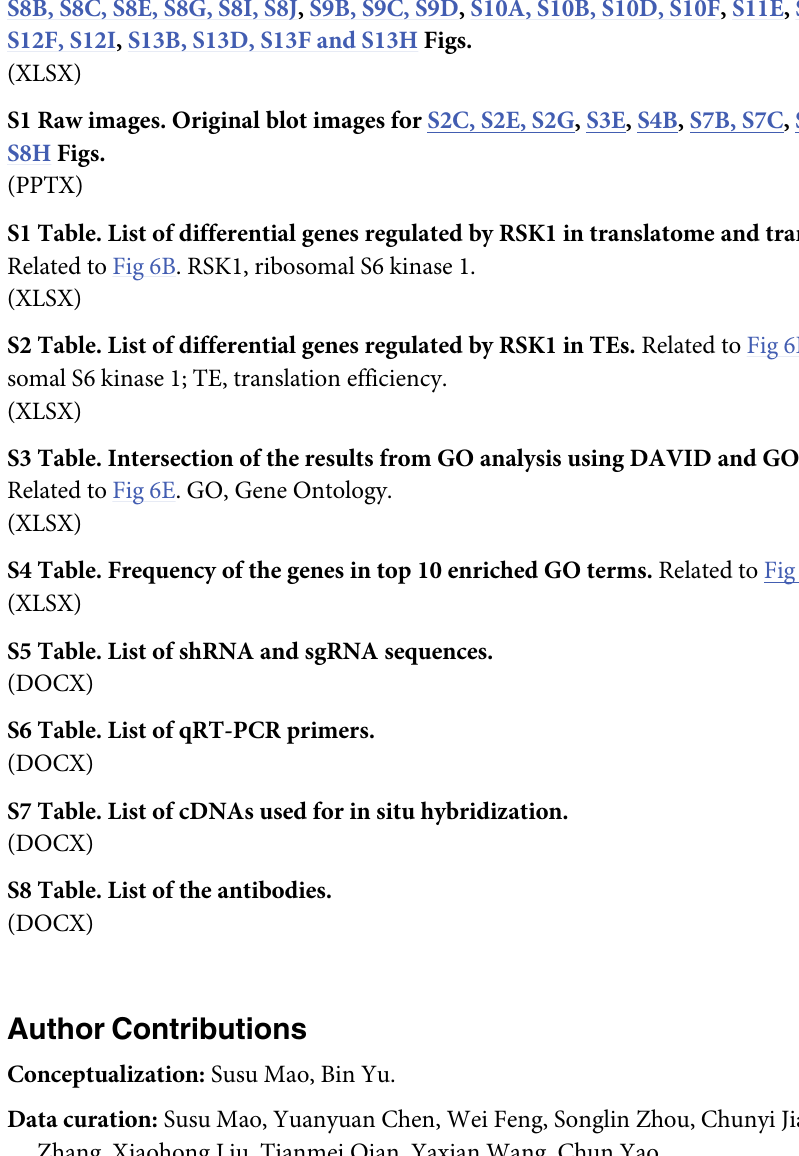
S1 Table. List of differential genes regulated by RSK1 in translatome and transcriptome. Related to Fig 6B. RSK1, ribosomal S6 kinase 1. S2 Table. List of differential genes regulated by RSK1 in TEs. Related to Fig 6D. RSK1, ribo- somal S6 kinase 1; TE, translation efficiency. S3 Table. Intersection of the results from GO analysis using DAVID and GO Resource. Related to Fig 6E. GO, Gene Ontology. S4 Table. Frequency of the genes in top 10 enriched GO terms. Related to Fig 6E. S5 Table. List of shRNA and sgRNA sequences. S6 Table. List of qRT-PCR primers. S7 Table. List of cDNAs used for in situ hybridization. S8 Table. List of the